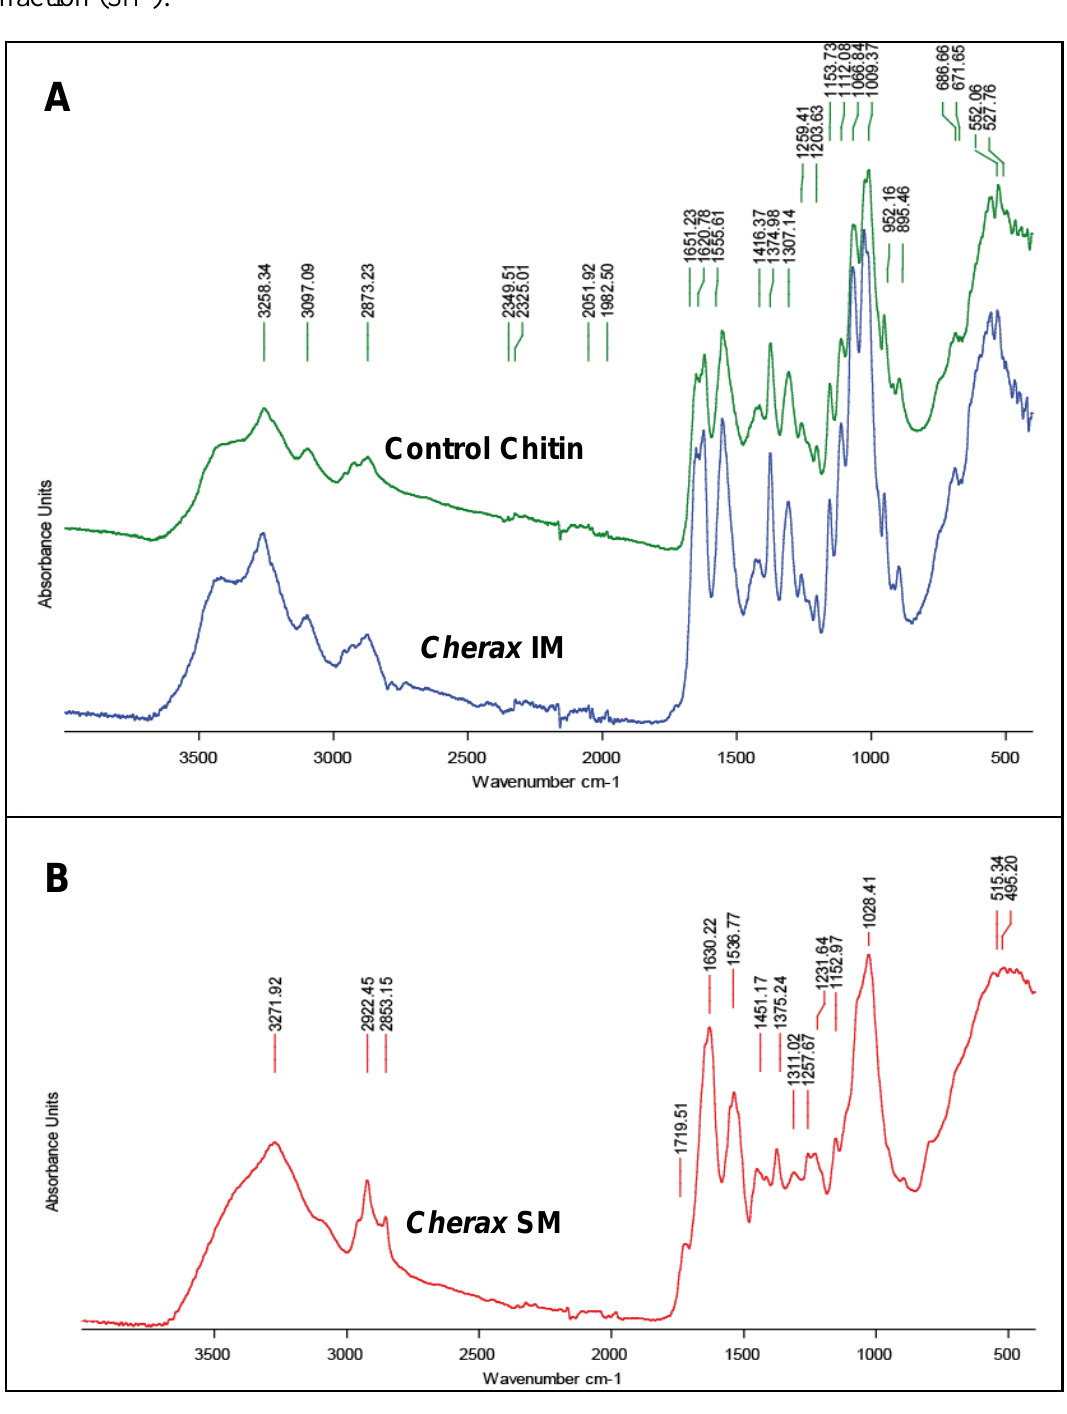
Figure 7. FTIR spectra of organic matrix fractions of gastrolith from Cherax quadricarinatus . A: Spectrum of the acid acetic-insoluble fraction (IM). This spectrum is similar to a control king crab chitin spectrum. B: Spectrum of the acid acetic-soluble fraction